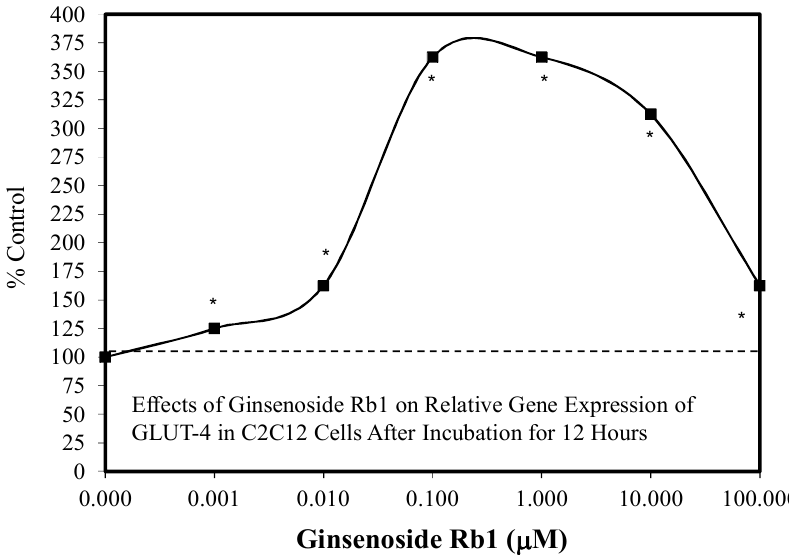
Figure 20. Effects of ginsenoside Rb1 on relative gene expression of GLUT-4 in C2C12 cells after incubation for 12 hours (source: [85]). Each * represent statistical significance for a data point.